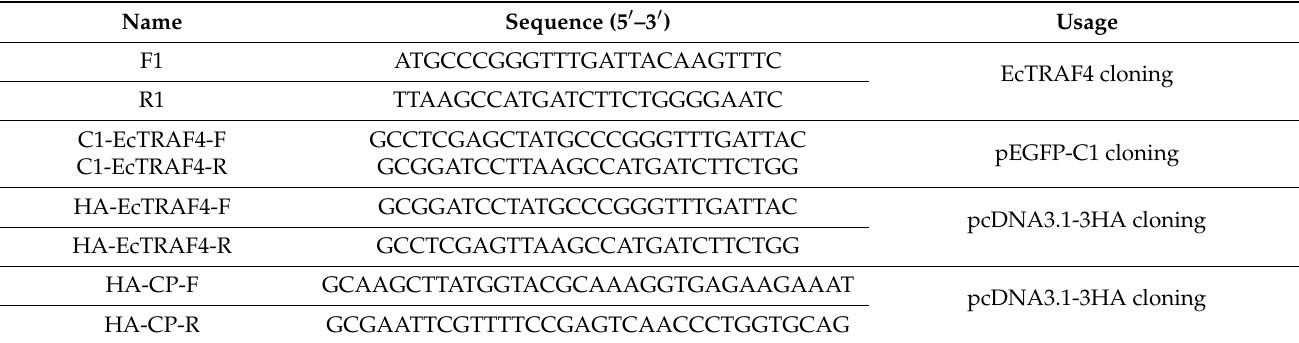
Table 2. Primers used for EcTRAF4 cloning and plasmid